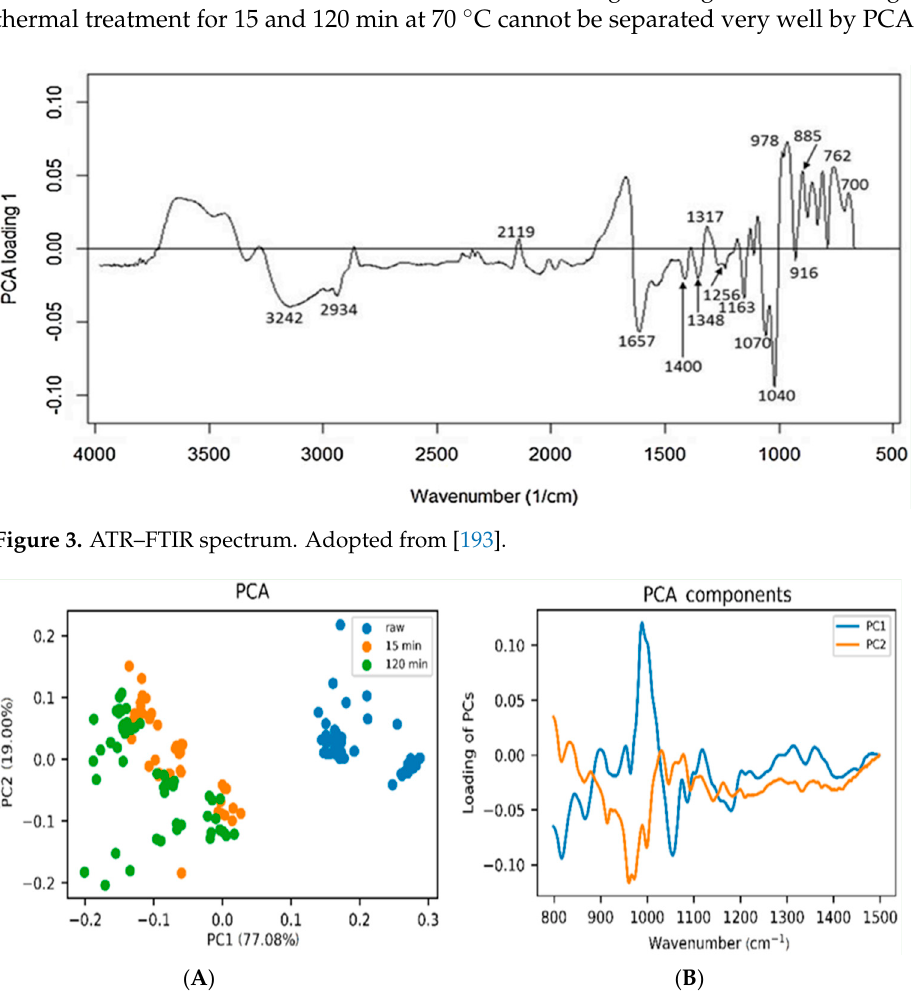
Figure 5. LDA plots based on ATR-FTIR data of the region 800–1500 cm − 1 ; left—Samples heated at 70 ° C, right—Samples heated at 40 ° C. Dots: training set, triangles: test set. Adopted from [215]. Chen et al. (2014) have studied manually dehydrated raw honey by using synchro- nous two-dimensional (2D) NIR correlation spectroscopy. Honey samples were taken